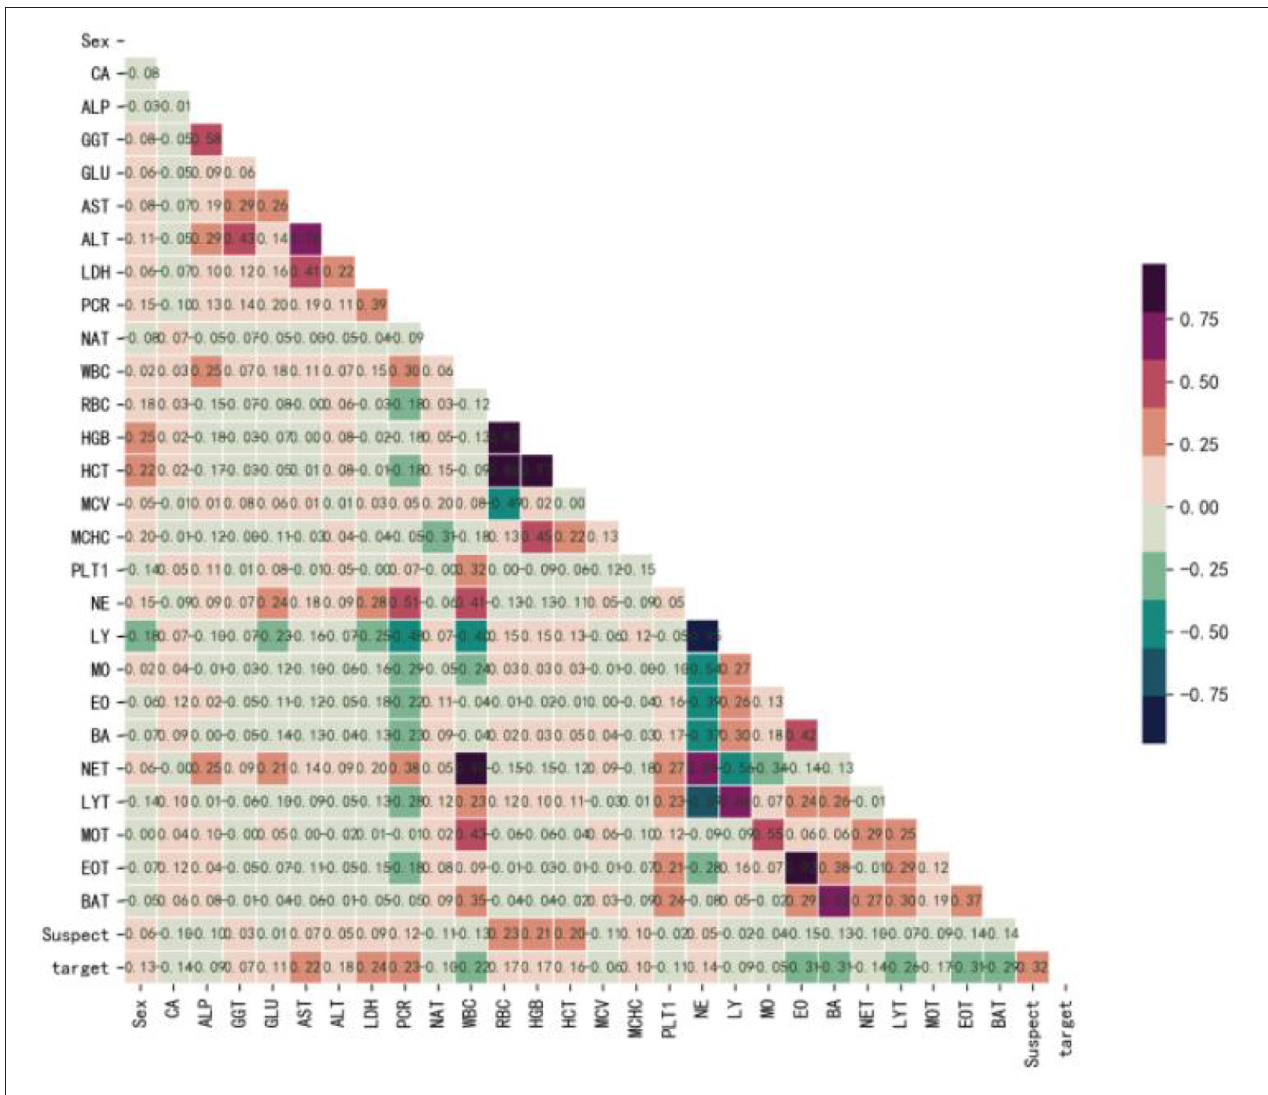
FIGURE 1 | Correlation coefficient matrix heatmap of all 29 variables. The obtained numerical matrix is visually displayed through a heatmap. Orange indicates a positive correlation, and green indicates a negative correlation. Color depth indicates the value of the coefficient, with deeper colors indicating stronger correlations. Specifically, redder colors indicate correlation coefficients closer to 1, and greener colors indicate coefficients closer to −